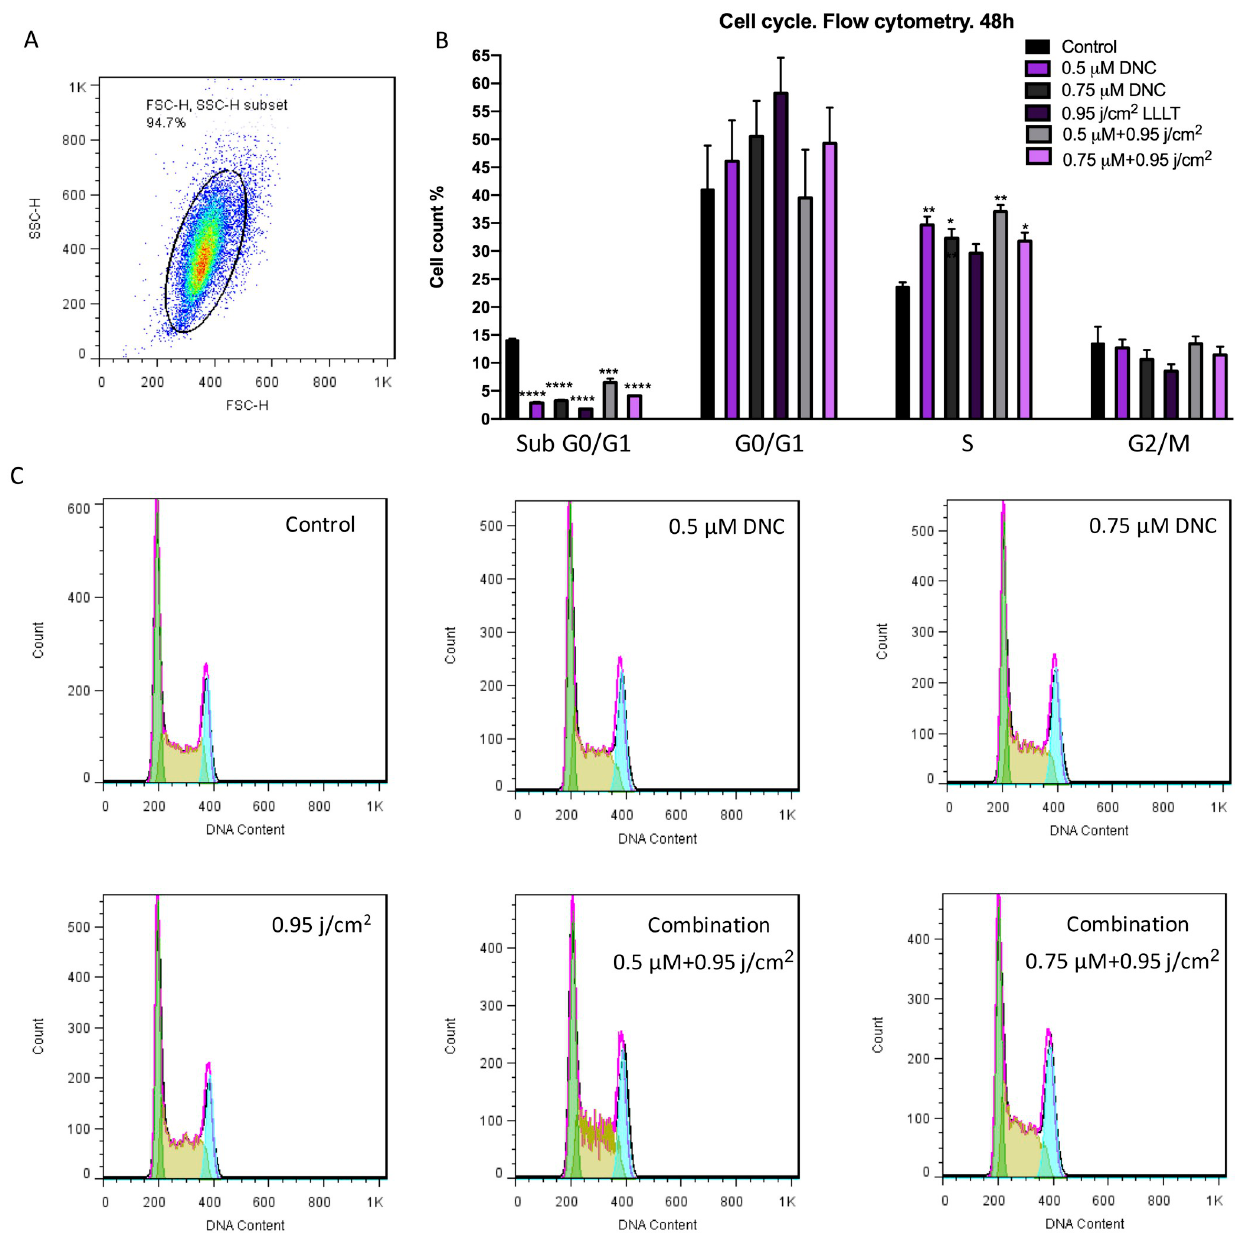
Fig 7. Flow cytometry analysis of cell cycle in MEFs after 48h post-treated with optimal doses of DNC, LLLT (450 nm) and combination treatment. (A) Graph represents the cell population under the study using FlowJo Software. (B) Cell cycle distribution of DNC, LLLT and DNC+LLLT treated MEFs after 48h. (C) Histogram of cell cycle analysis of MEFs exposed with DNC, LLLT and combination treatment after 48h. The results are shown as the mean ± SEM of triplicate experiments ( � : P < 0.05, �� : P < 0.01, ��� : P < 0.001, ���� : P < 0.0001).